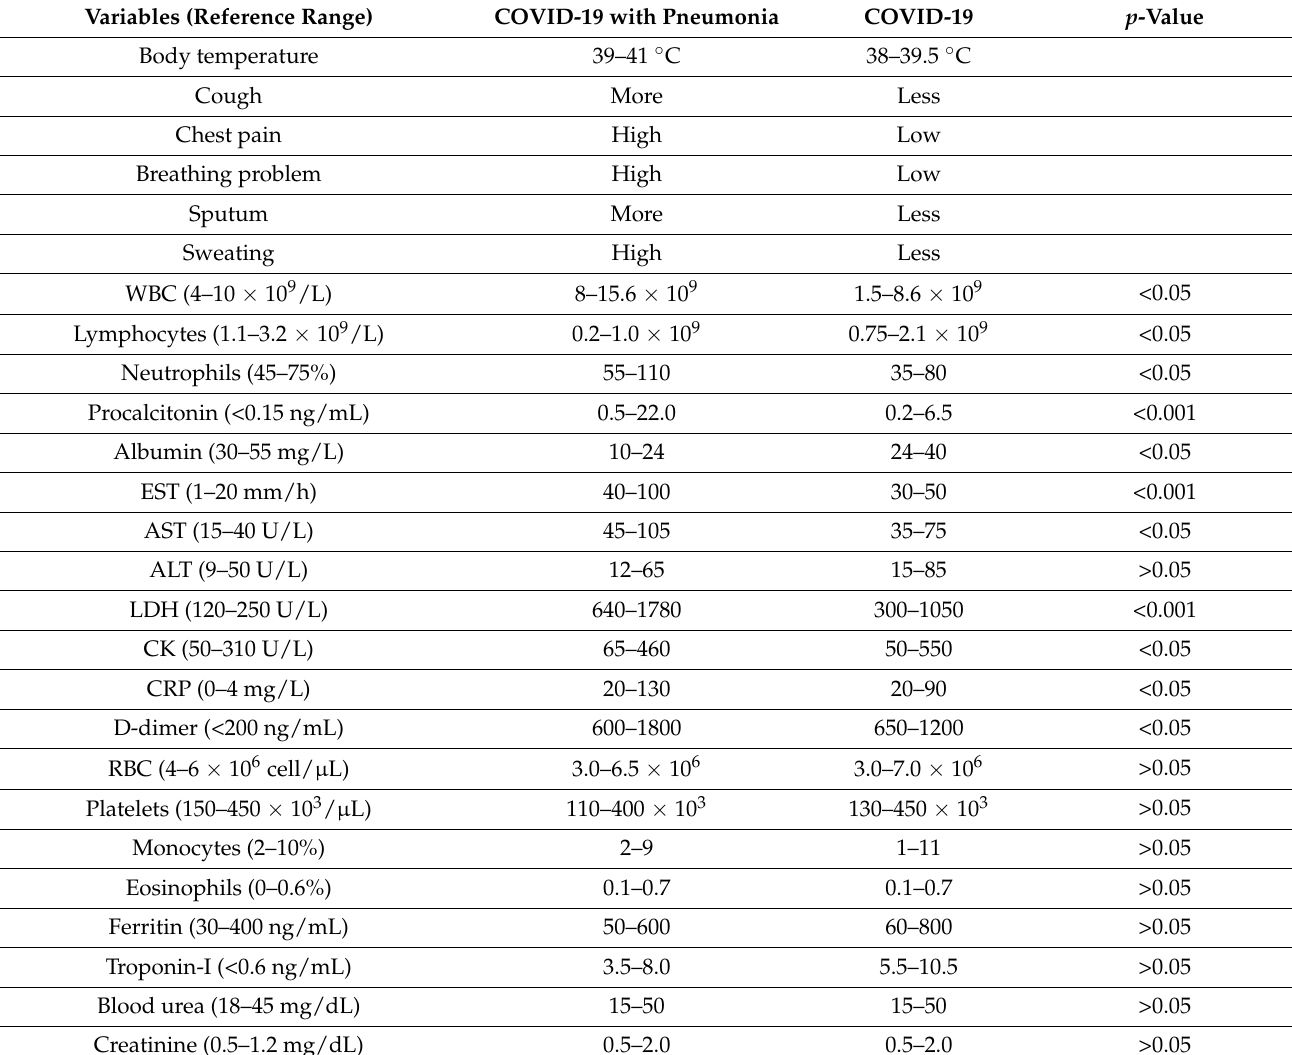
Table 2. Clinical characteristics of COVID-19 patients with and without